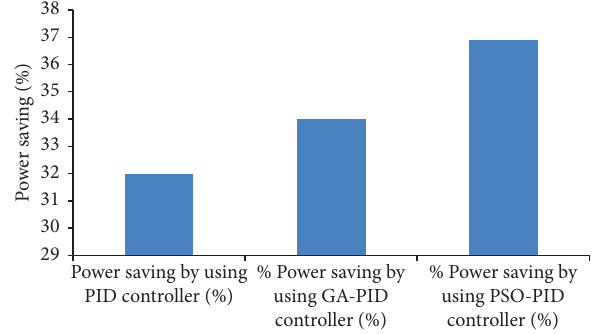
Figure 21: % of saving power of exhaust